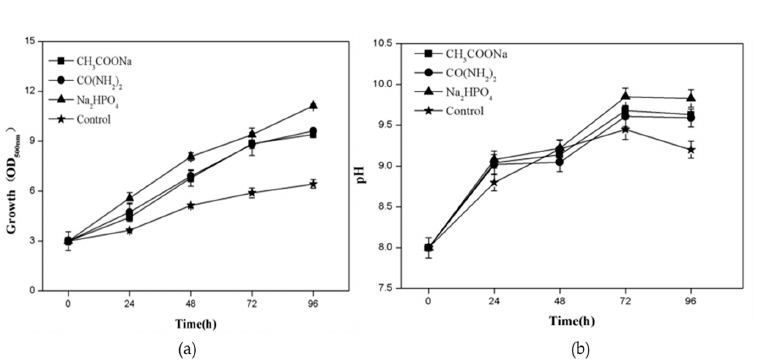
Fig. 2. Effects of CH growth (a) and pH(b).